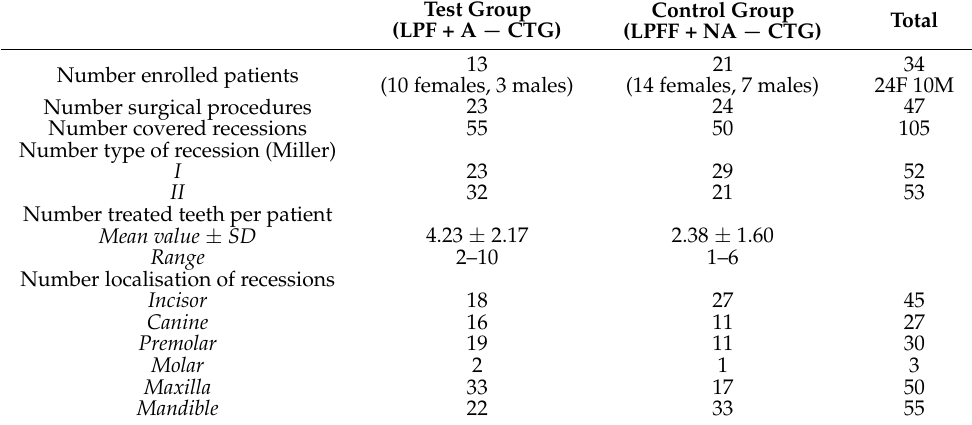
Table 1. Patient related